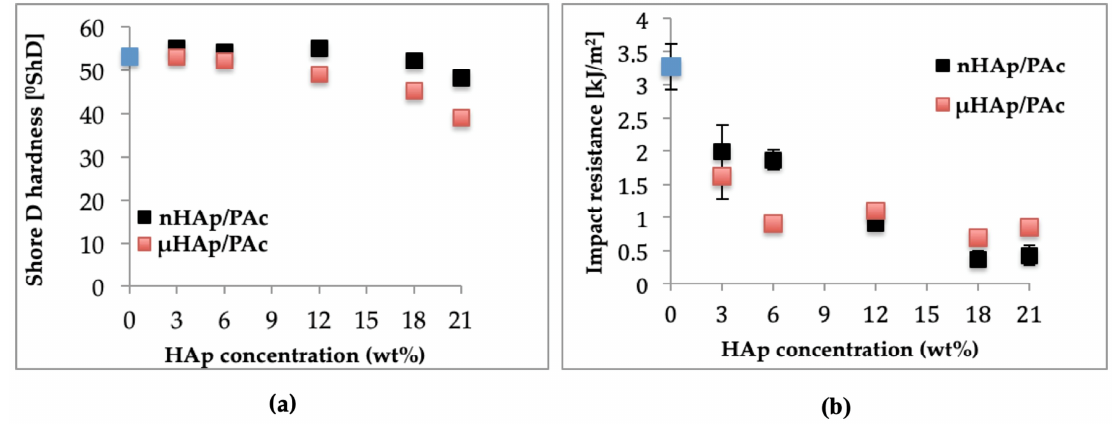
Figure 11. Dependencies of ( a ) hardness and ( b ) impact strength of the composite on the type and concentration of the HAp filler.